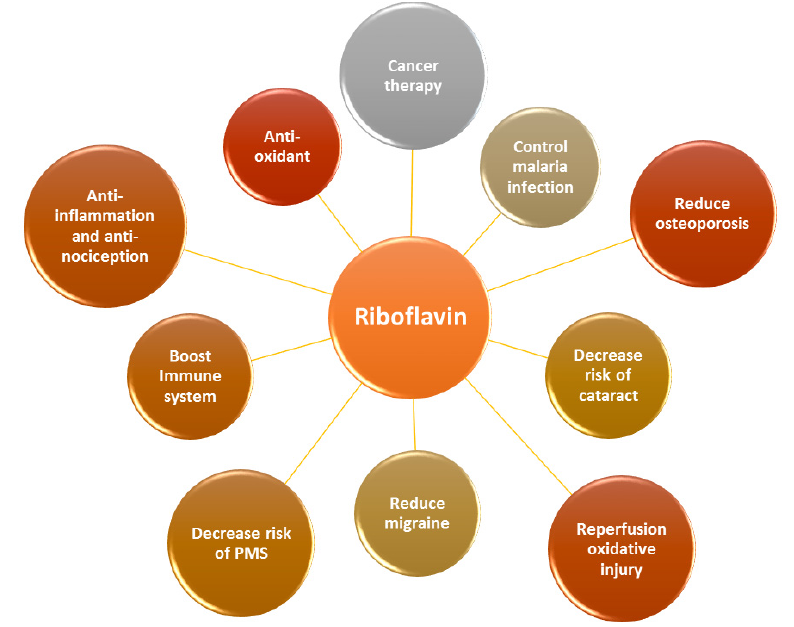
Figure 2. RF is an essential vitamin for multiple physiological aspects in the body.